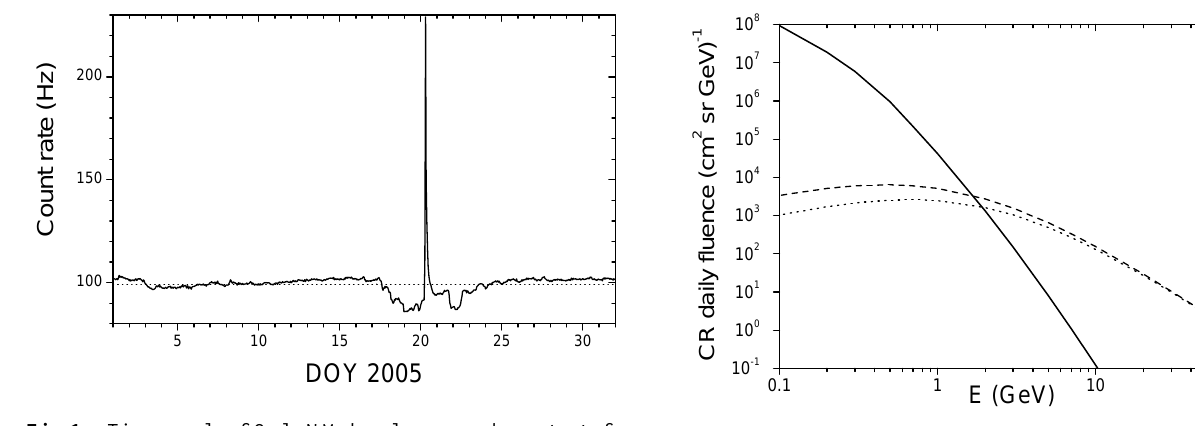
Fig.1. TimeprofileofOuluNMhourlyaveragedcountrateforJanuary2005(http://cosmicrays.oulu.fi). Fig. 1. Time profile of Oulu NM hourly averaged count rate for Thedottedlinerepresentstheaveragedmonthlycountrateforthemonth. January 2005 (http://cosmicrays.oulu.fi). The dotted line represents at the early recovery phase of the Forbush decrease when the background suppression of the the averaged monthly count rate for the month. NMcountratewasabout10%. Duringthefollowingtwodays,anadditionalsuppressionofthe CR intensity occurred, making the overall time profile even more complicated. Atmospheric effects of this event have been studied by different groups (e.g. B¨utikofer et al., 2008; Damiani et al., 2008; Sepp¨al¨a et al., 2008; Mishev et al., 2010), but they were 8